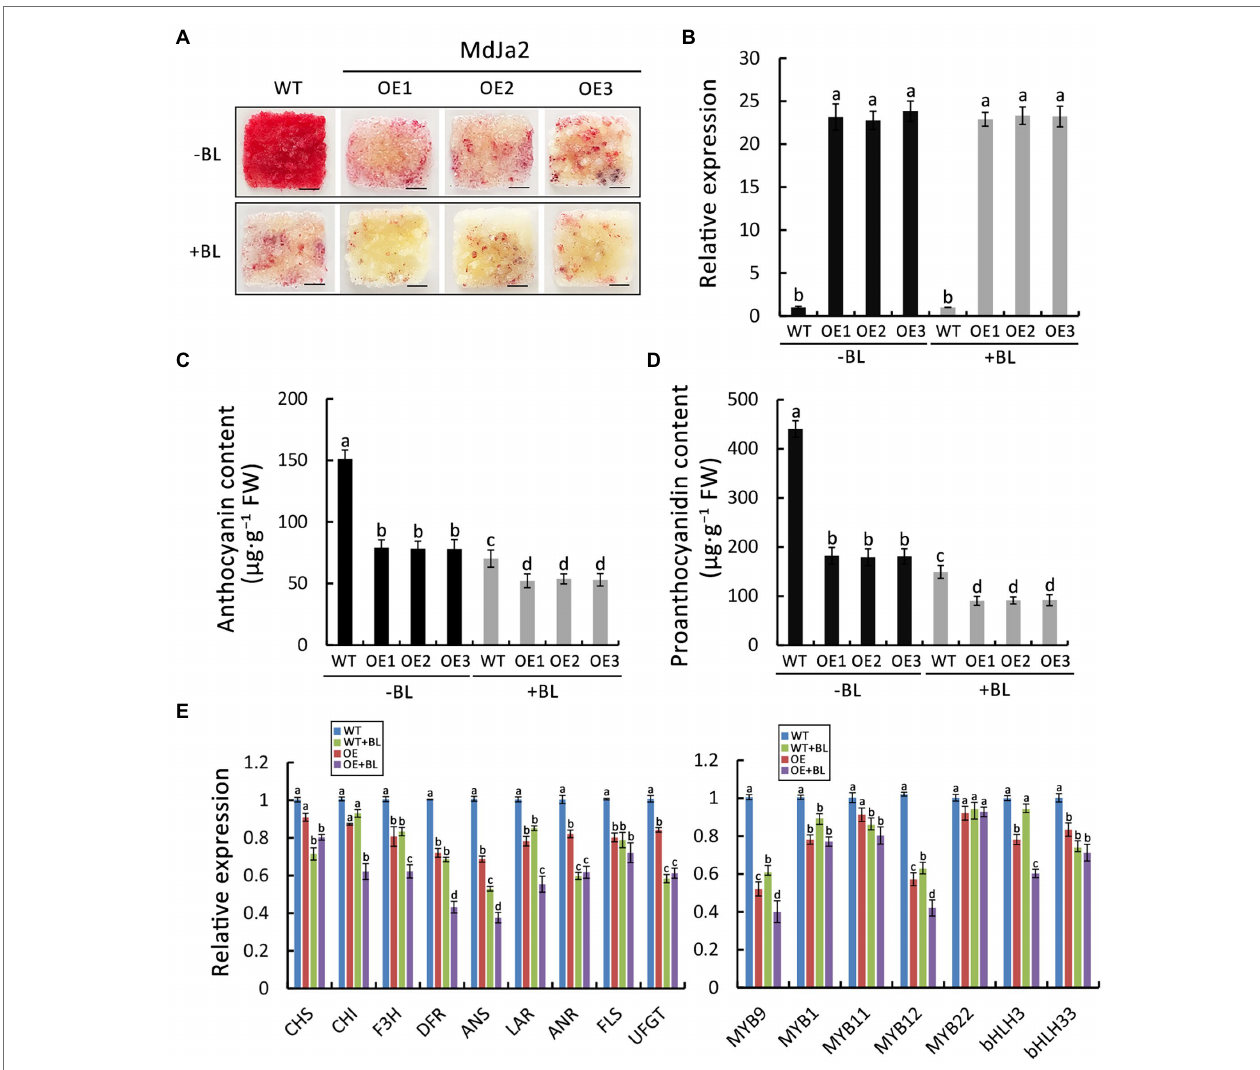
FIGURE 3 | Effect of BL-treatment on anthocyanin and proanthocyanidin synthesis in OE-MdJa2 red-fleshed apple calli. (A) Phenotypes of MdJa2 -overexpressing ( OE-MdJa2 ) apple calli grown on MS medium with or without 1 μ M BL. The experiment was performed at least three times. Scale bar = 1 cm. (B) qPCR analysis of MdJa2 transcript in WT and transgenic apple calli. (C,D) Anthocyanin and proanthocyanidin contents in wild-type (WT) and transgenic lines with or without BL- treatment. (E) Expressions of the genes related to flavonoid synthesis in OE-MdJa2 and WT red-fleshed apple calli with or without 1 μ M BL as determined by qRT- PCR. Statistical significance is indicated by different lowercase letters ( p < 0.05